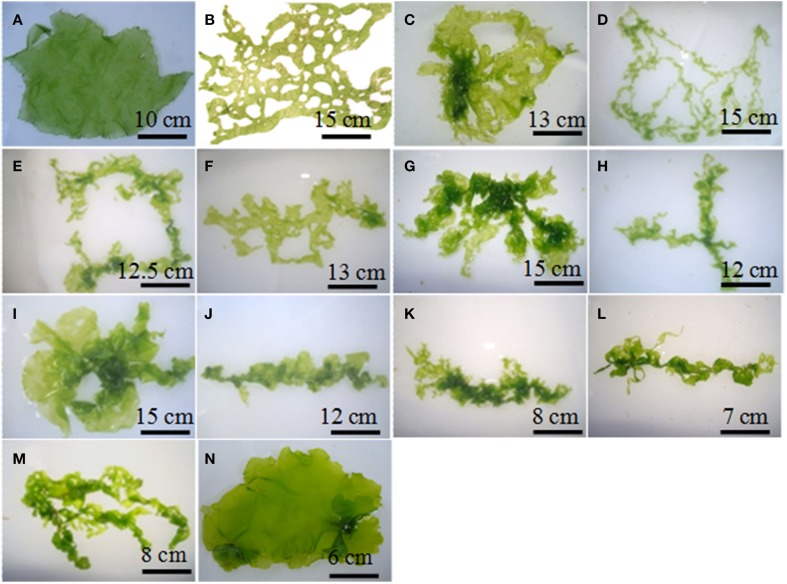
The morphology of fusion partners and putative hybrids generated after protoplast fusion. (A)
M. oxyspermum and (B)
U. reticulata, (C–N) putative hybrids. The age of the hybrids represented in the figure is 4 months.